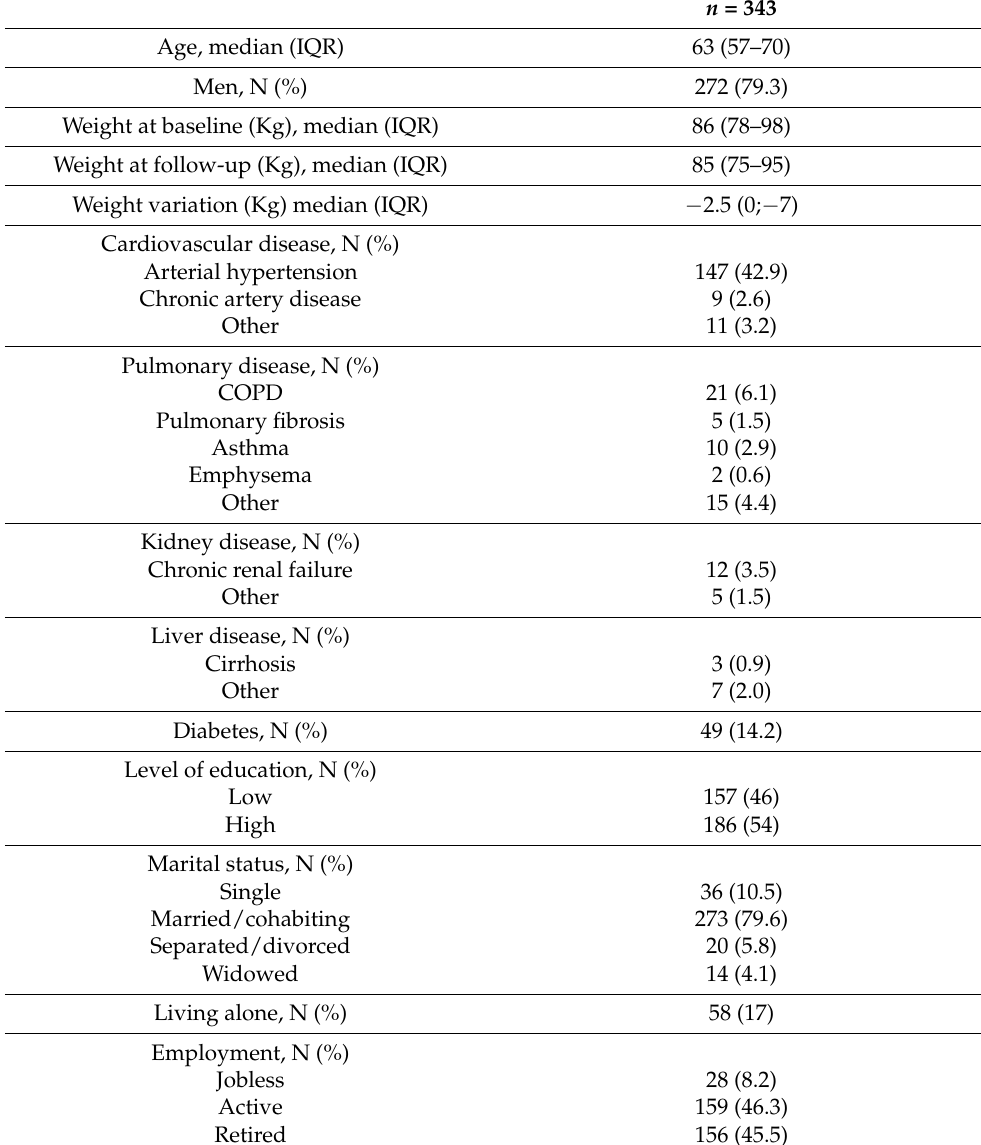
Table 1. Baseline patients’ characteristics.